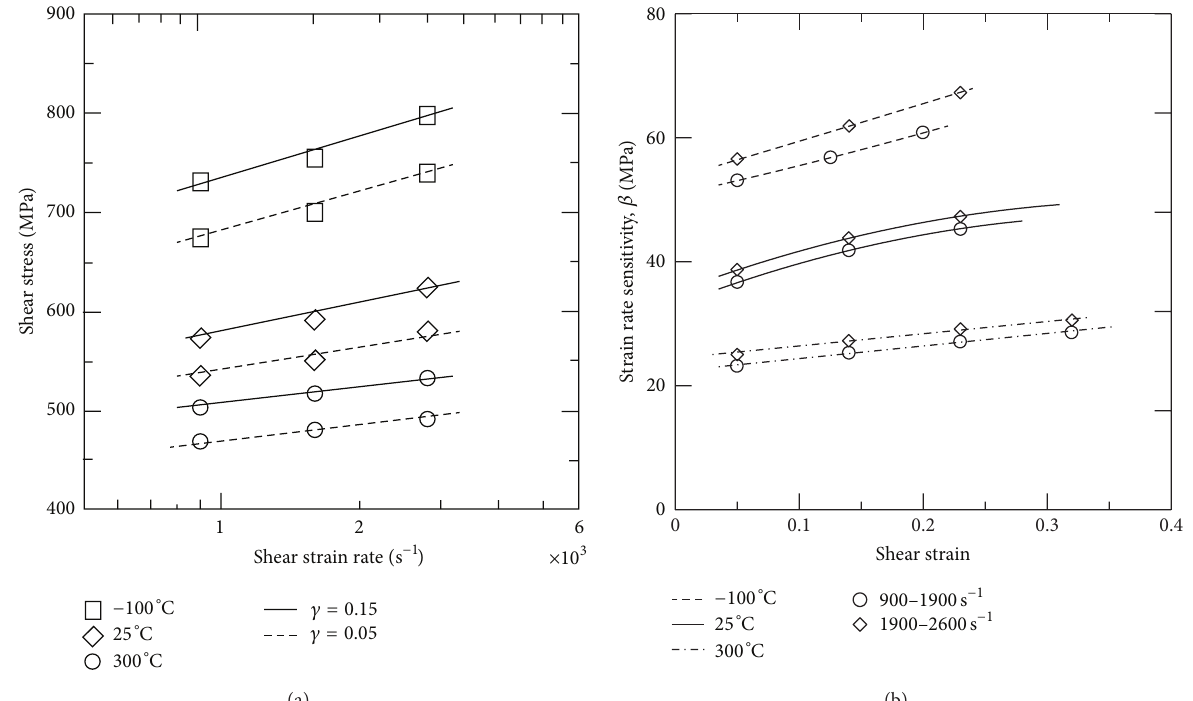
Figure 3: (a) Variation of shear stress with logarithmic strain rate as a function of temperature for constant shear strains of 0.05 and 0.15. (b) Variation of strain rate sensitivity with shear strain as a function of temperature and strain rate.